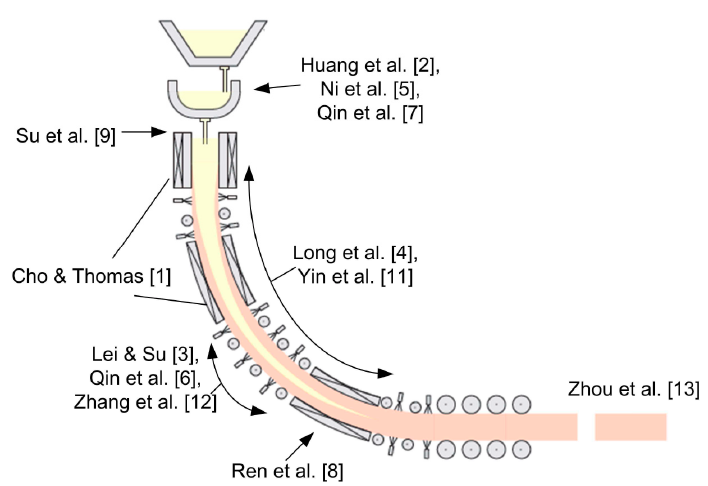
Figure 2. Schematic relating the articles in this special issue to the continuous casting of steel.